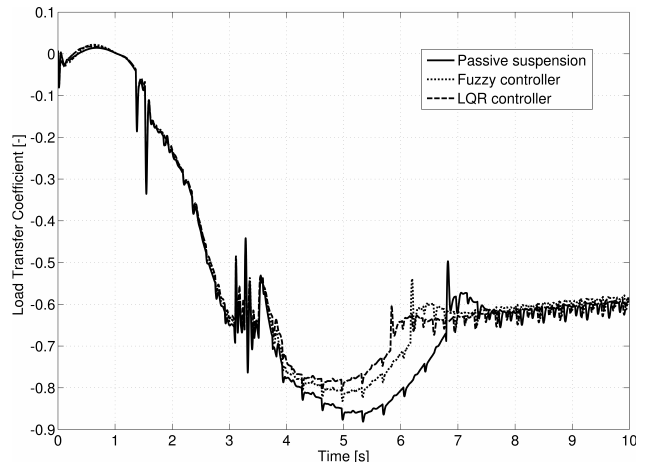
Figure 11. Bank angle estimation for Test 2.